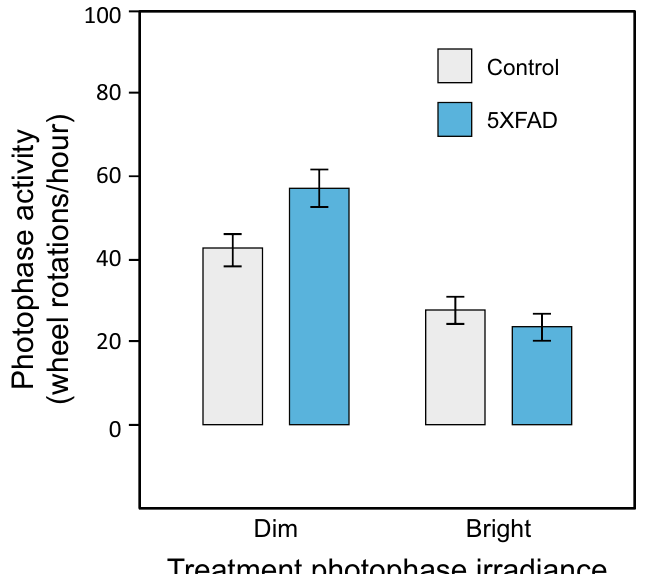
Figure 4. Mean photophase activity with respect to treatment photophase irradiance and genotype (pooled for sex). A significant interaction between the main effects of treatment photophase irradiance and genotype on photophase activity was observed. The error bars represent standard error of the